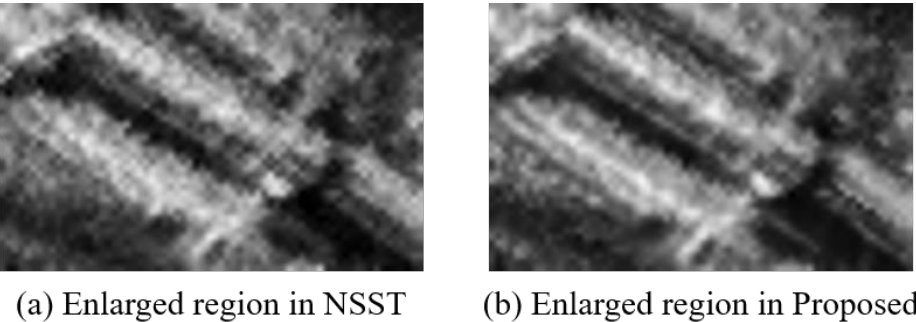
Figure 8. Enlarged marked region in scene 2: ( a ) Enlarged marked region in the NSST fusion and ( b ) enlarged marked region in the proposed method fusion.